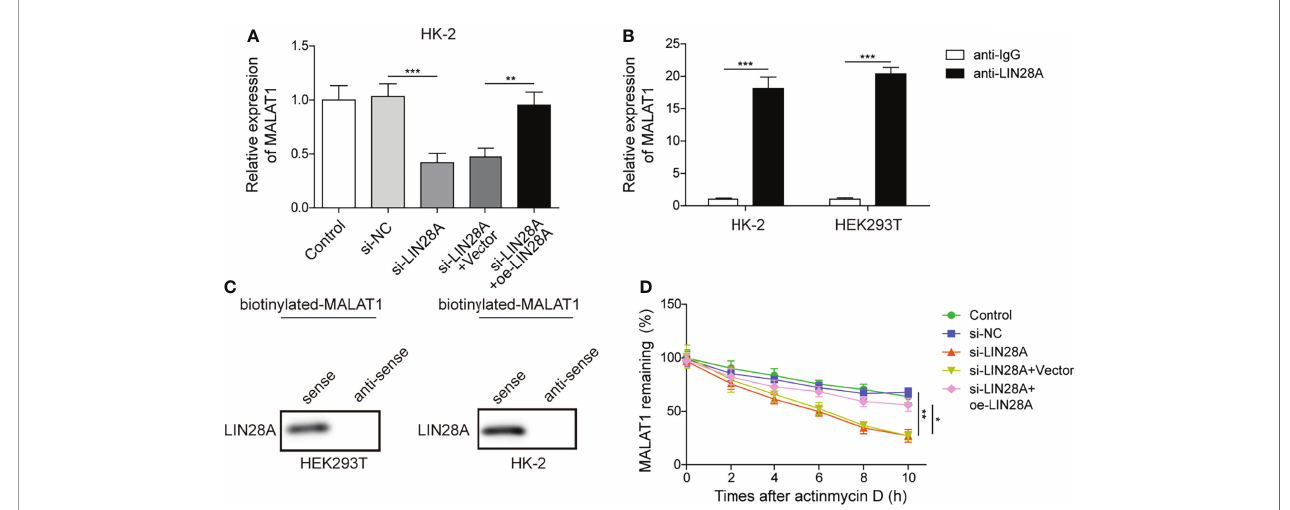
FIGURE 3 | MALAT1 interacted with LIN28A in HK-2 cells. (A) qRT-PCR analysis of MALAT1 in HK-2 cells transfected with si-NC, si-LIN28A, si-LIN28A + vector or si-LIN28A + oe-LIN28A (n=4). (B) The enrichment of MALAT1 in anti-LIN28A-immunoprecipitated fractions from HK-2 and HEK-293T cells was analyzed by qRT- PCR (n=3). (C) LIN28A was pulled down by the MALAT1 sense probe (n=3). (D) MALAT1 stability in HK-2 cells in response to actinomycin D (n=4). * P < 0.05, ** P < 0.01 and *** P <